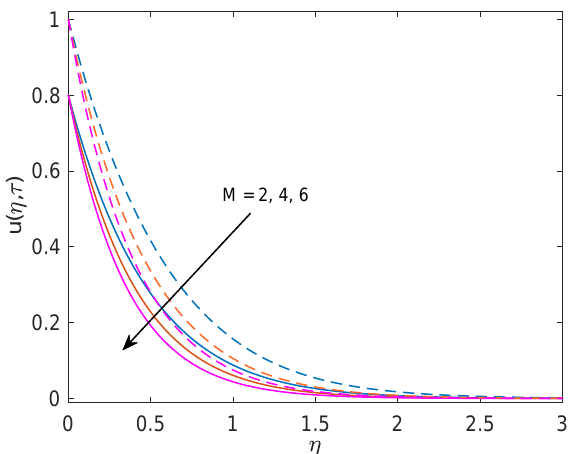
Figure 4. Effect of different values of